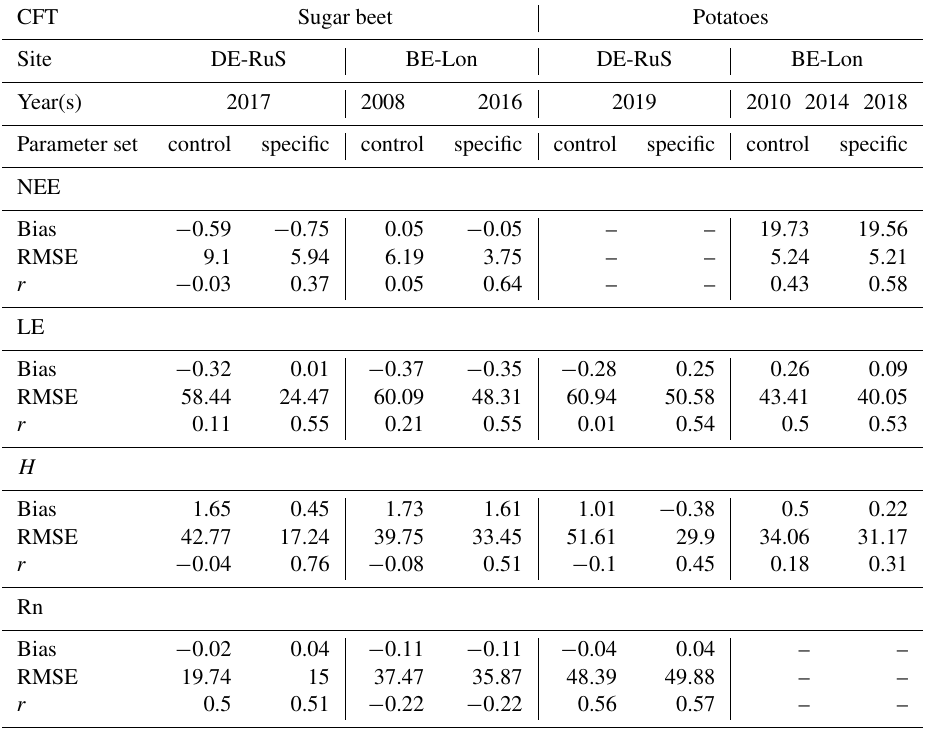
Table 5. Bias, root-mean-square error (RMSE), and Pearson correlation coefficient ( r ) for the simulated daily NEE (µmolCO 2 Wm − 2 s − 1 ), LE (Wm − 2 ), H (Wm − 2 ), and Rn (Wm − 2 ) using the crop-specific parameterization (specific) for the CFTs sugar beet and potatoes at the sites BE-Lon and DE-RuS, respectively. Results are compared to those from the control simulation runs (control). Values were calculated over the time period between recorded planting and harvest dates (averaged over all respective CFT years at each site) using simulation output and observation data at daily time